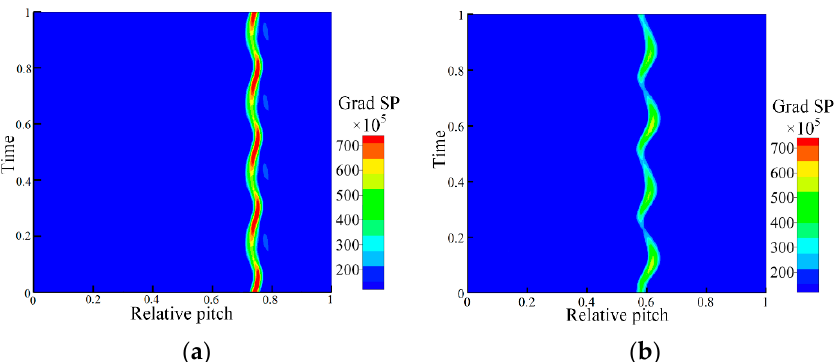
Figure 13. Time-space diagram of the shock at the middle vane height of the two models: ( a ) base model; ( b ) SSGV model.